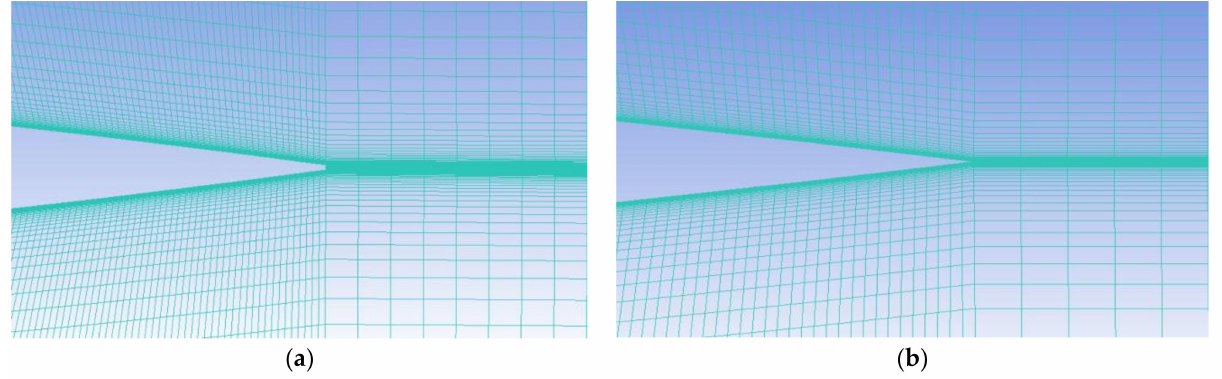
Figure 5. ( a ) Close view of grids near the blunt trailing edge; ( b ) close view of grids near the sharp trailing